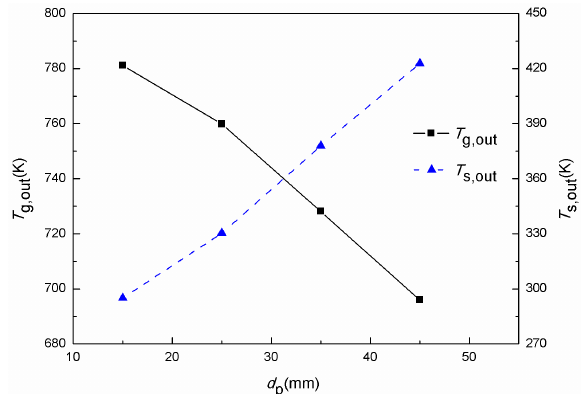
Figure 15. Influence of the sinter particle diameter on the outlet air temperature and outlet sinter temperature.